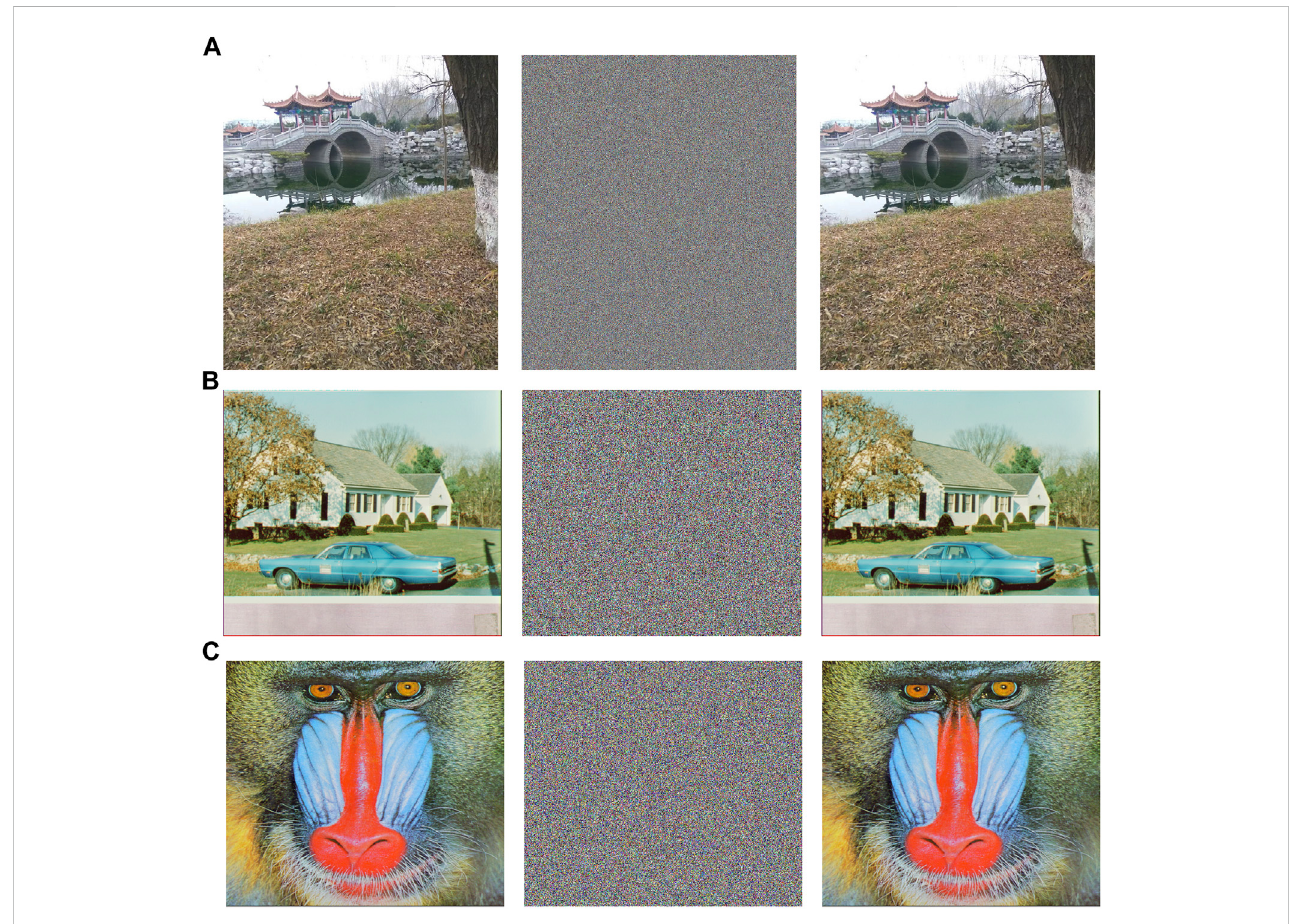
FIGURE 4 Experimentresults: (A) istheencryptionanddecryptionresultofthebridgeofsize1,440 · 1,080, (B,C) standfortheencryptionanddecryptionresultofthe baboon of size 512 · 512, and the encryption and decryption result of the house whose size is 512 · 512.